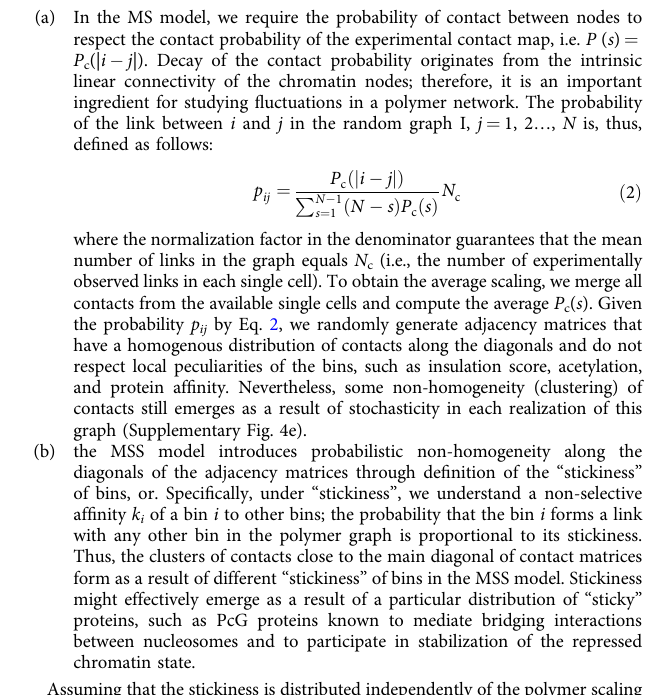
Epigenetic analysis of TAD boundaries . For the functional annotation of TAD boundaries, we downloaded modENCODE normalized array fi les 85 : total RNA of ML-DmBG3-c2 cell line assessed by RNA tiling array (modENCODE id 713) and the ChIP-chip for MOF (id 3041), BEAF-32 (id 921), Chriz (275), CP190 (924), CTCF (3280), dmTopo-II (5058), GAF (2651), H1 (3299), HP1a (2666), HP1b (3016), HP1c (942), HP2 (3026), HP4 (4185), ISWI (3030), JIL-1 (3035), mod